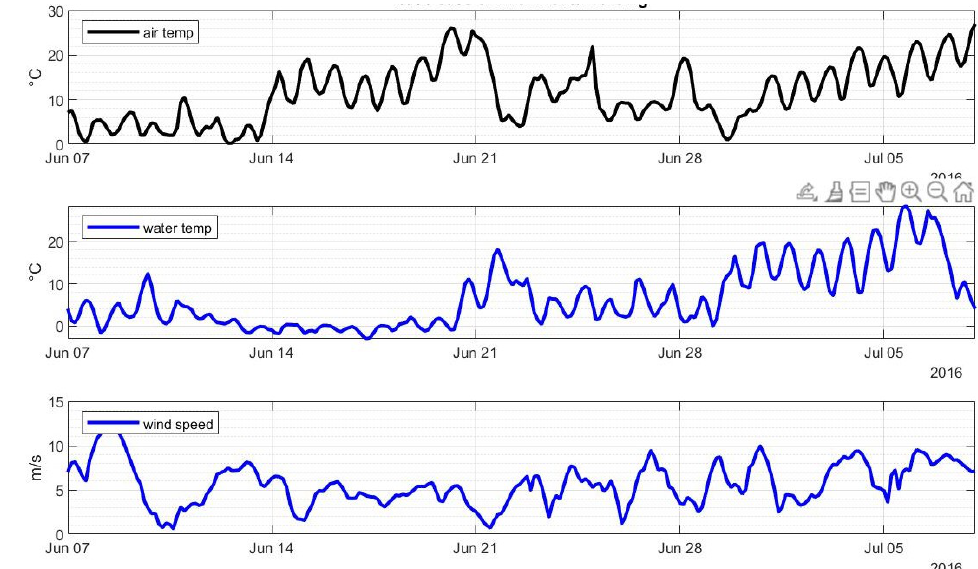
Figure A9. Environmental forcing of the base case.